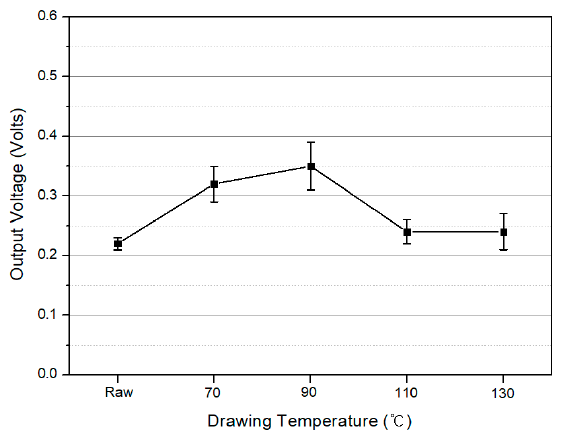
Figure 13. Output voltages of the PVDF/PAR composites as conditions of drawing temperature under a pressure of 30 N (Unpoled).